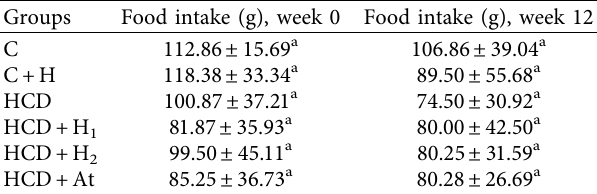
Table 1: Effect of 1% cholesterol diet and Trihoney on animal’s food intake.